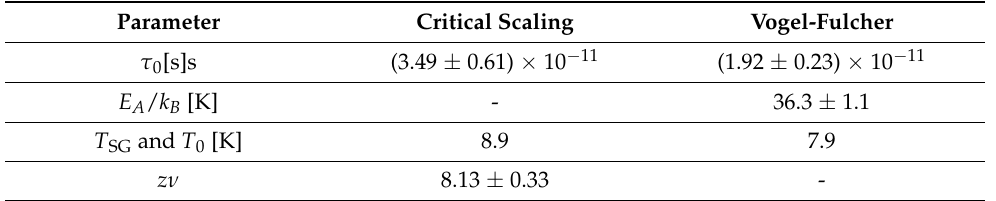
Table 2. Parameters obtained from the data in Figure 4 fitted with the critical scaling approach and Vogel-Fulcher law.